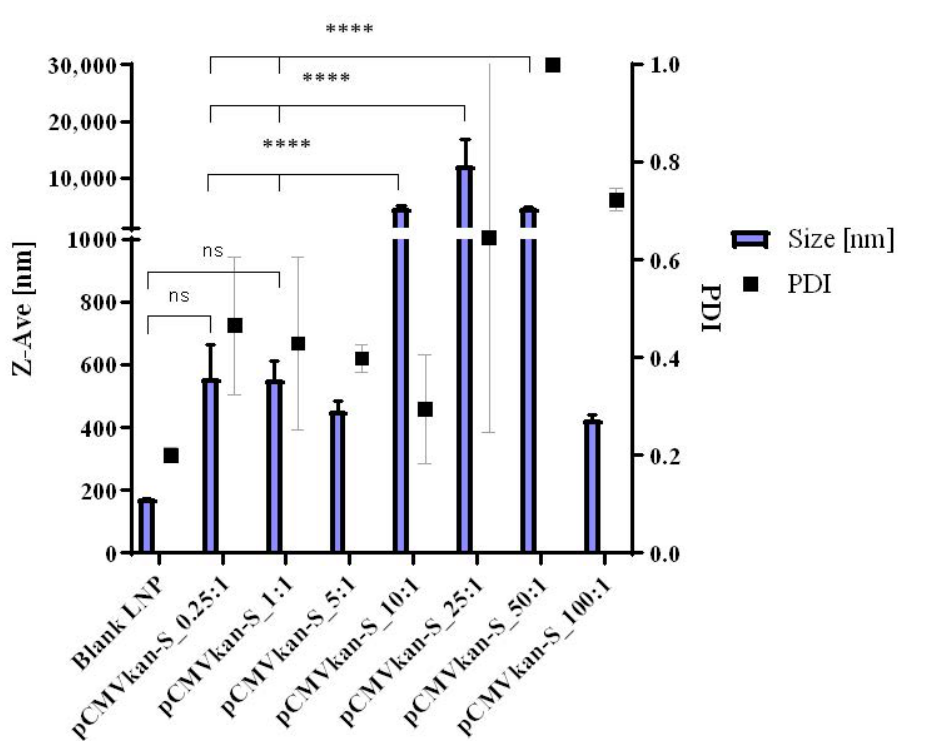
Figure 4. DLS results for DOTAP4/pCMVkan-S complexes at different N/P ratios, Z-Ave [nm], and PDI are plotted and jointly analyzed in this graph. Results are compared to blank liposome size profile. Lipoplex data were measured 30 min after liposome-DNA complexation at various N/P ratios. Data are presented as mean ± SD. **** indicates p < 0.0001, ns = p > 0.05, not statistically significant when compared to other groups.